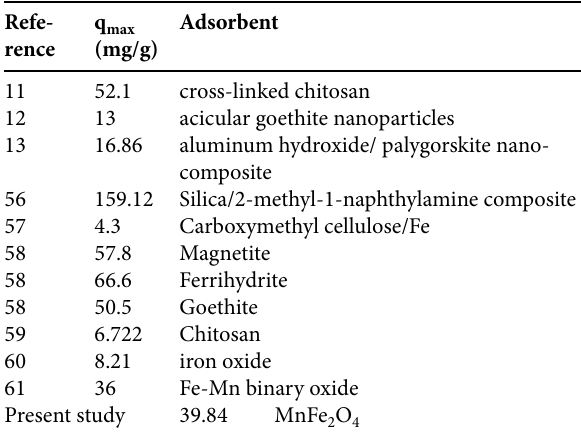
Table 3. Comparing the maximum sorption capacity of P ions using various adsorbents